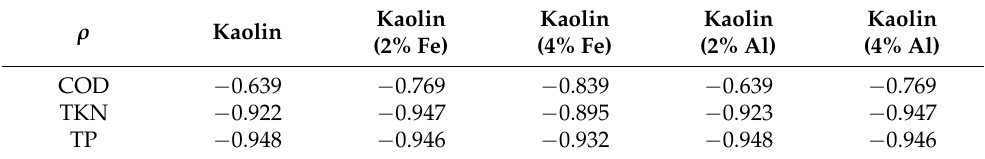
Table 4. Average correlation ( ρ ) measurements between FR and leachate parameters of clay soil samples.